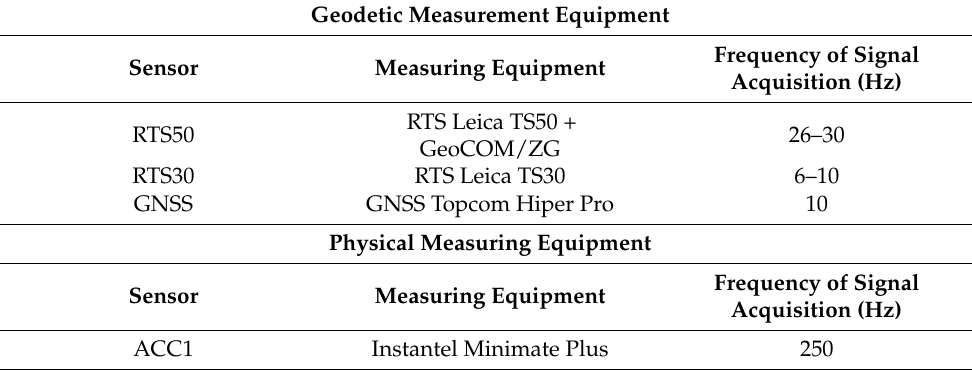
Table 1. Basic characteristics of measuring equipment.